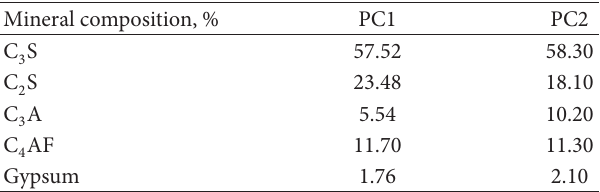
T 2: Mineral composition of initial